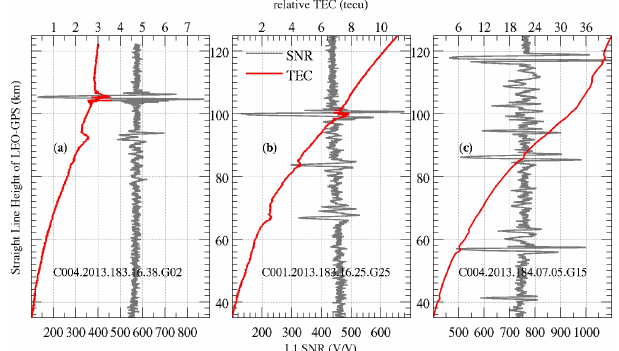
Figure 2. Selected examples of two (a) , three (b) , and multiple ( c ; in this case, seven) peaks in the L1 SNR and relative slant TEC versus straight line height observed by COSMIC